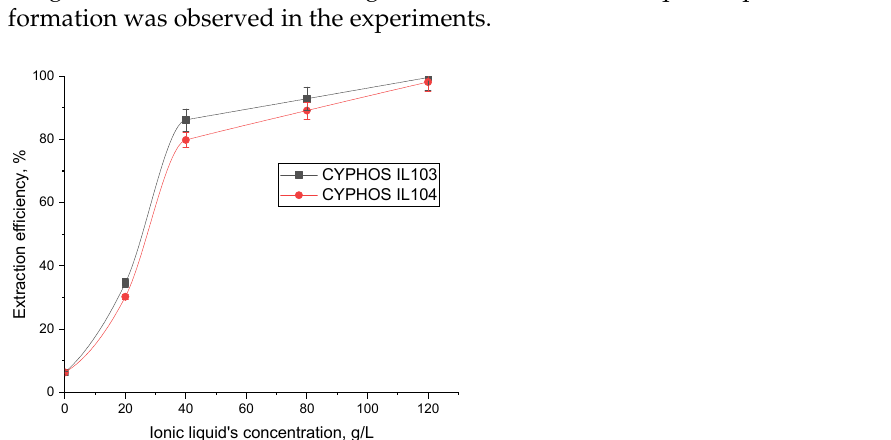
Figure 4. Aqueous phase pH in fl uence on extraction e ffi ciency (ionic liquid concentration 40 g/L).